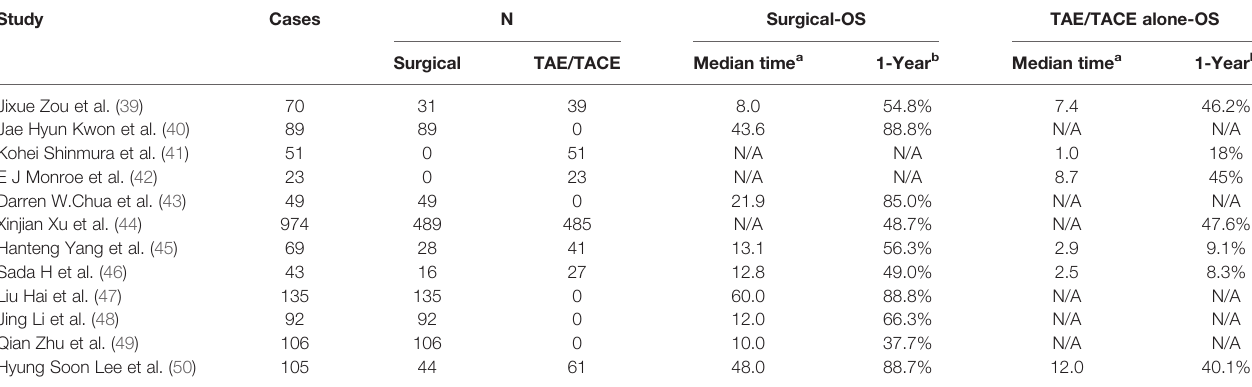
TABLE 1 | Main treatment methods and clinical results of ruptured hepatocellular carcinoma in a published series.